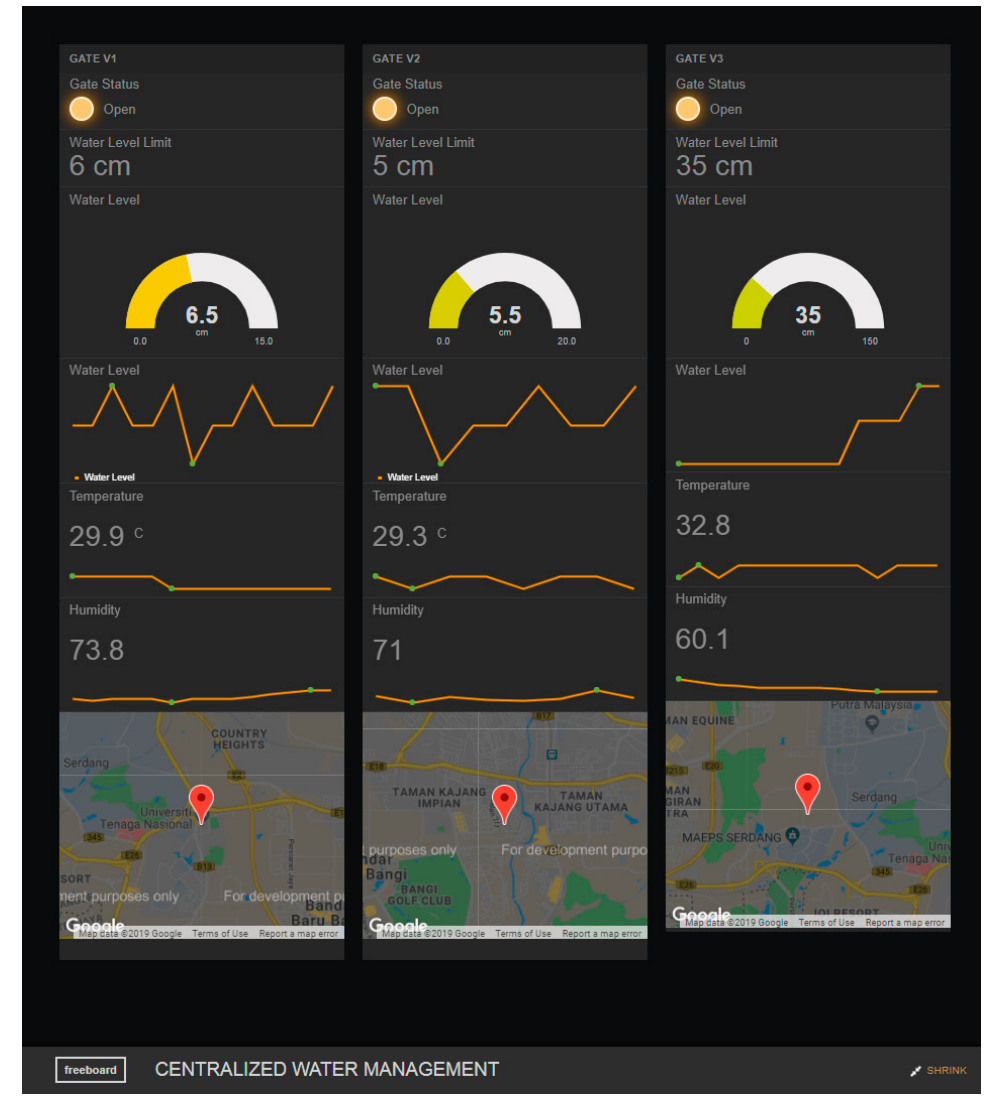
Figure 15. Publishing gate data to the cloud.